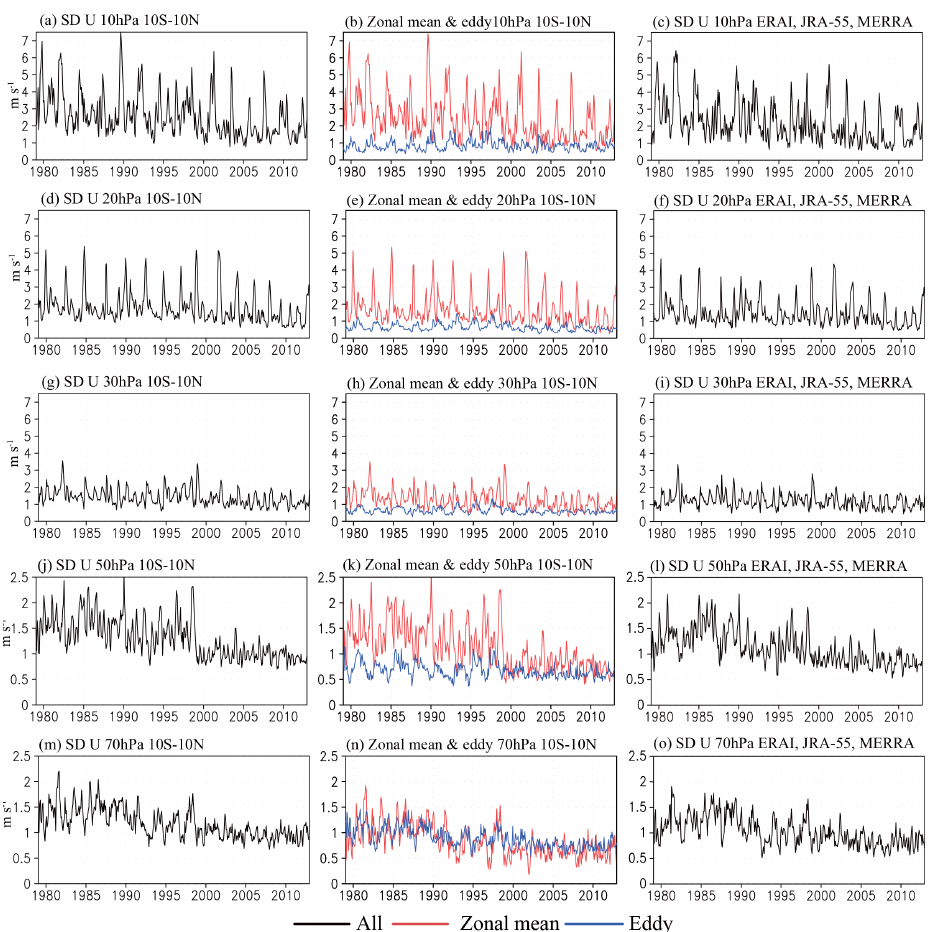
Figure 13. Time variations of zonal mean standard deviation of (black) all, (red) zonal mean, and (blue) eddy components among (left and middle) four reanalyses (ERA-I, JRA-25, JRA-55, and MERRA), and among (right) three reanalyses (ERA-I, JRA-55, and MERRA) from 1979 to 2012 at 10, 20, 30, 50, and 70hPa in 10 ◦ S–10 ◦